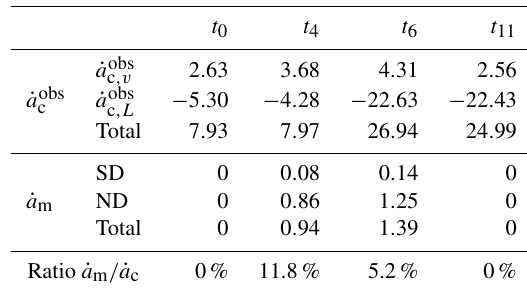
Table 4. Observed mean volumetric calving rate, ˙ a obs c = ˙ a obs c ,v − ˙ a obs , in 10 5 m 3 d − 1 , as the difference between the tangential (ice c ,L flow direction) ice velocity at the front and the rate of change of the frontal position integrated over the terminus domain, and estimated subaqueous melt rate, ˙ a m , in 10 5 m 3 d − 1